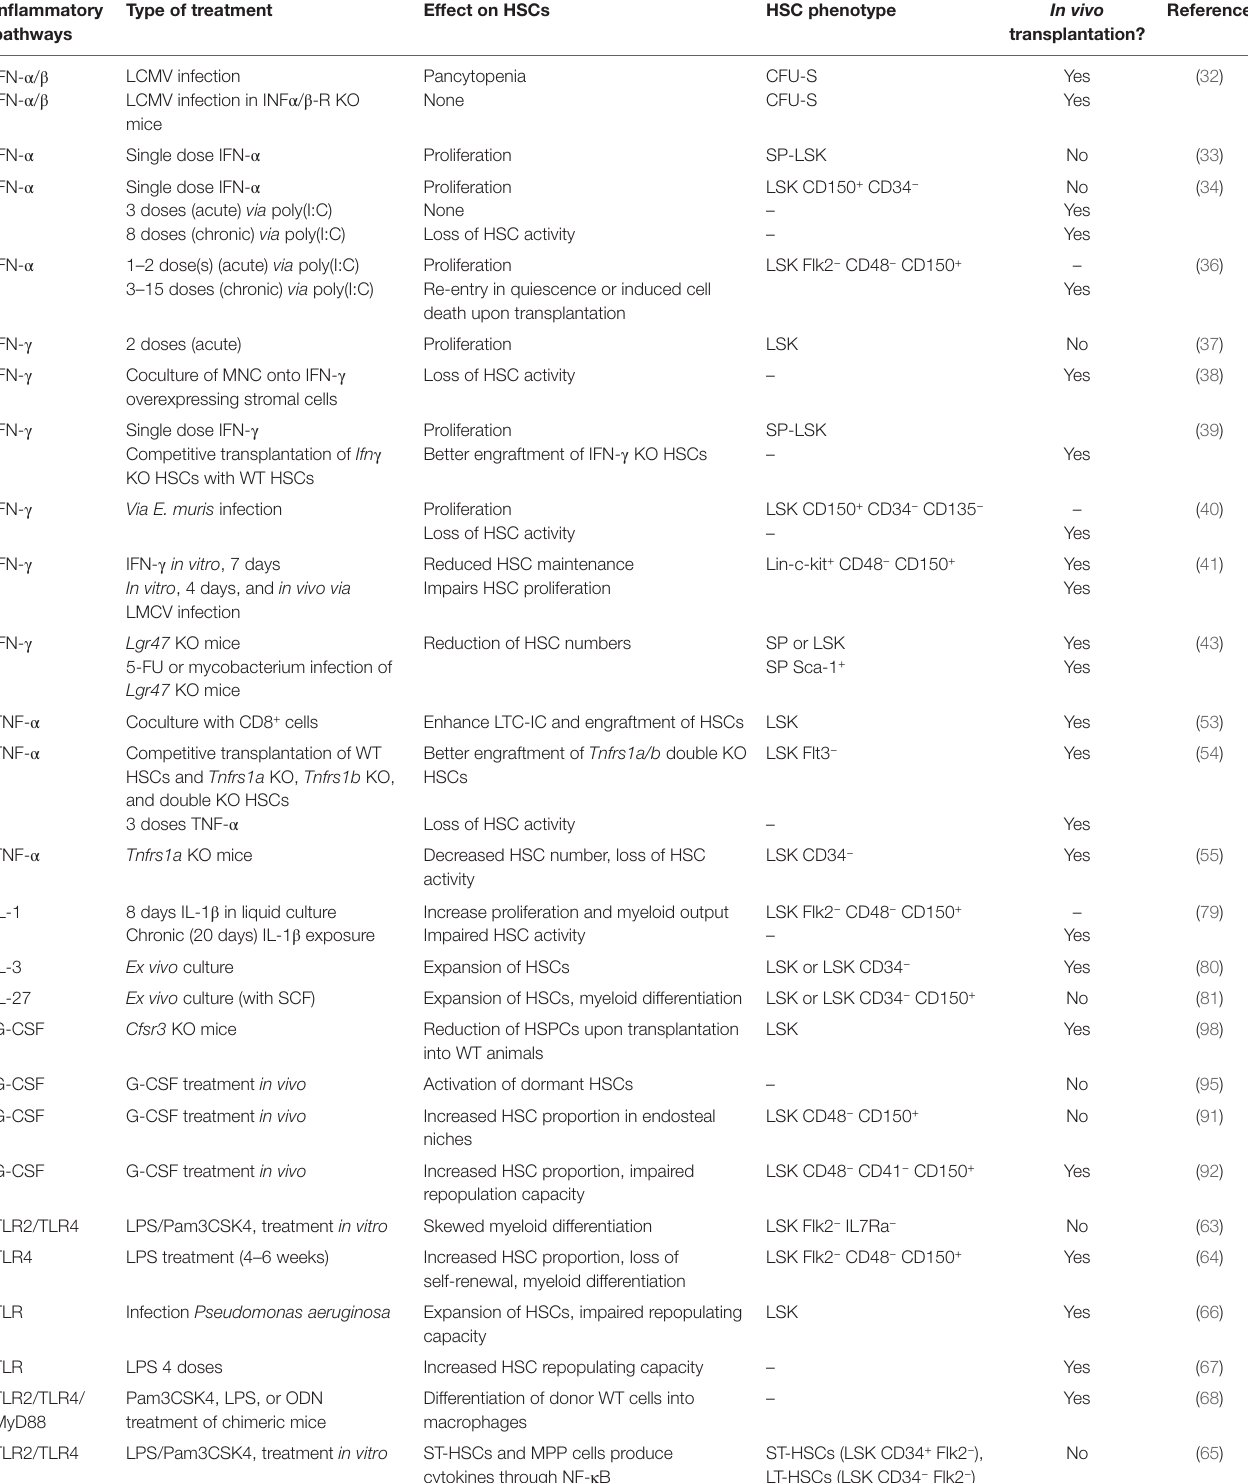
TABLe 1 | Murine inflammatory pathways and their role in HSCs. inflammatory